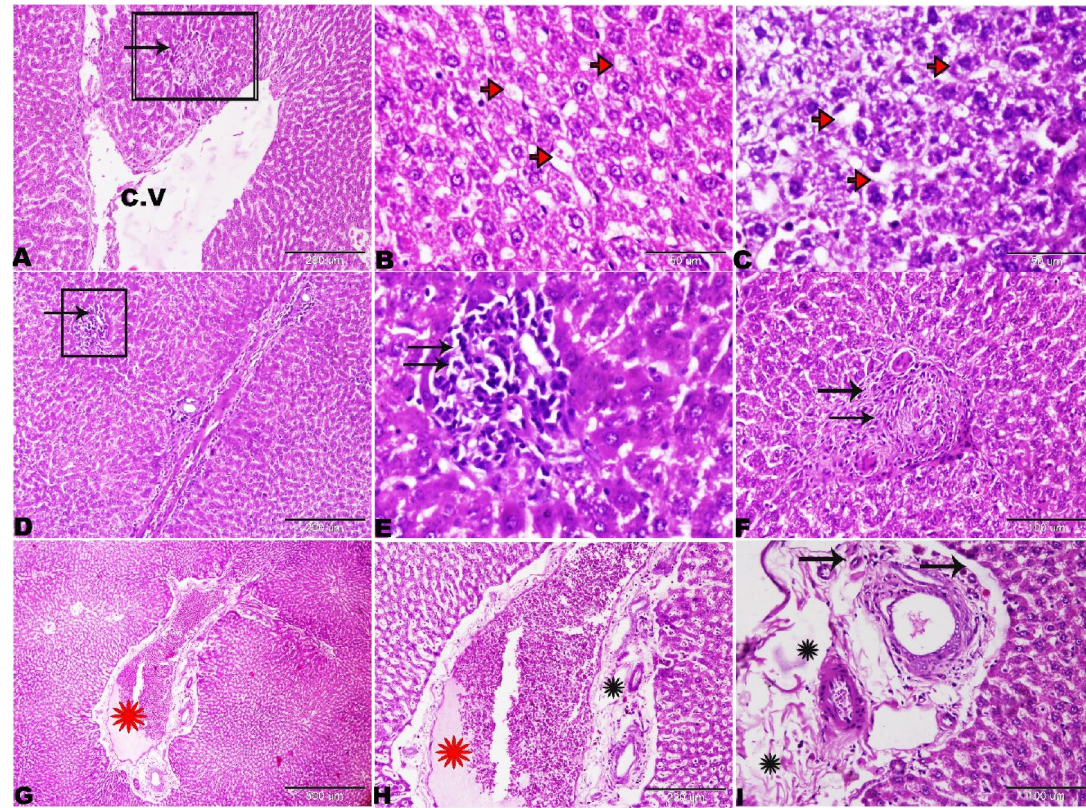
Figure 11. Photomicrograph of the rat livers of Group IV (basal diet 70% + cheese containing L. rhamnosus 30%). ( A ) Dilated central vein with degenerated endothelial lining (star), focal nodular hyperplasia (selected square). ( B , C ) Vacuolar degeneration of hepatocytes (red arrows). ( D ) Focal nodular hyperplasia (selected square) magnified in E. hyperplastic cells mixed with lymphocytic infiltration (arrows). ( F ) Focal nodular hyperplasia of the liver parenchyma and stellate scar with abnormal blood vessels. Part of the vessels showing a marked thickening of the wall without lumen (arrows). ( G , H ) Wide portal areas due to extensive widening and congestion in the portal veins (red star) and periportal edema (black star). I: periportal fibrosis and edema (stars) and newly formed bile ductulus (arrows). H&E stain, the bar size was indicated under